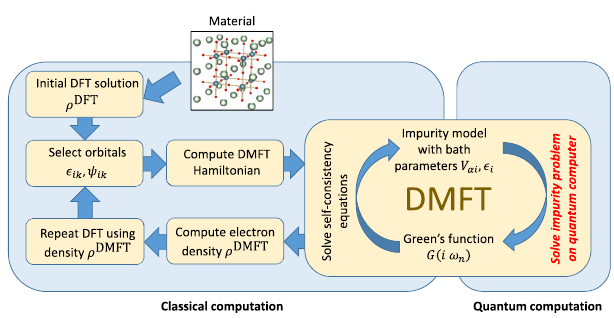
FIG. 1. Overview of the DFT þ DMFT approach. In our proposal, the solution of the impurity problem (highlighted in red), which is the computationally limiting step in computations using classical computers, is performed by a quantum